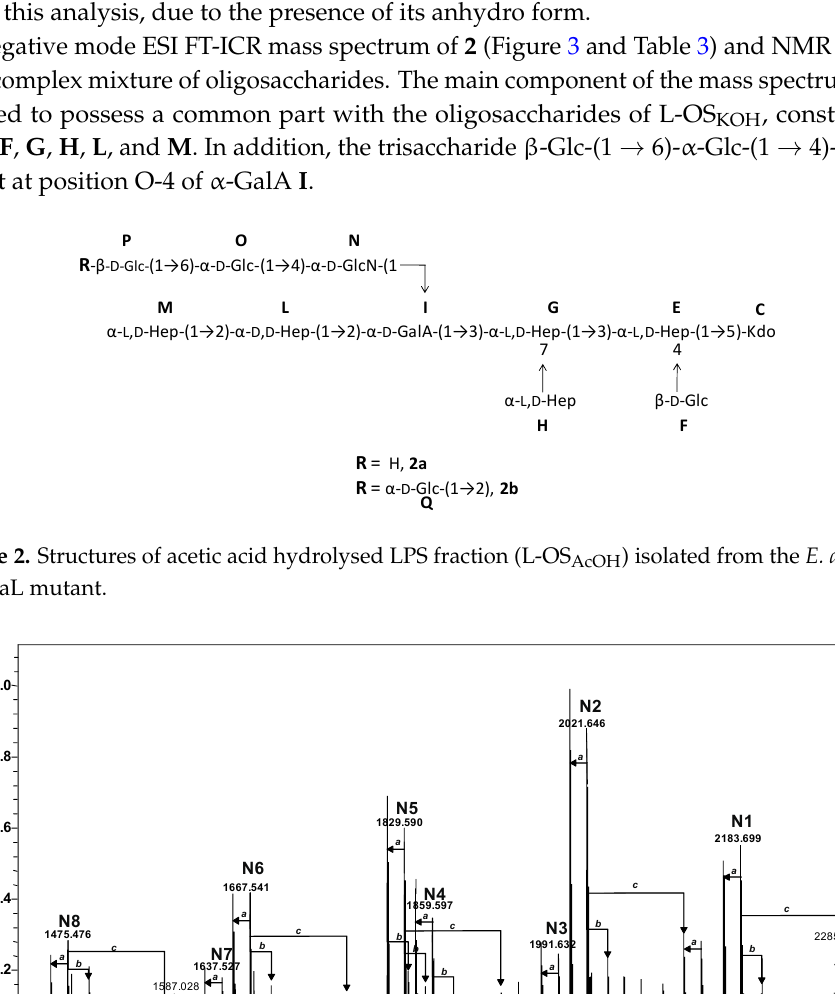
Figure 3. Charge deconvoluted ESI FT-ICR mass spectrum of supernatant of the acetic acid hydrolysed LPS fraction (L-OS AcOH ) isolated from E. amylowora waaL mutant. The spectrum was acquired in negative ion mode. The mass numbers given refer to the monoisotopic peak of the neutral molecular species. Further mass peaks originate from a: loss of H 2 O ( Δ m = − 18.010 u); b: sodium adducts [M − H + Na] ( Δ m = +21,979 u); c: an additional phosphate group (P − H + Na) ( Δ m = +101.948 u). Table 3. Composition of the main species observed in the charge deconvoluted ESI FT-ICR mass spectrum of supernatant of the acetic acid hydrolysed LPS fraction (L-OS AcOH ) isolated from E. amylowora waaL mutant.